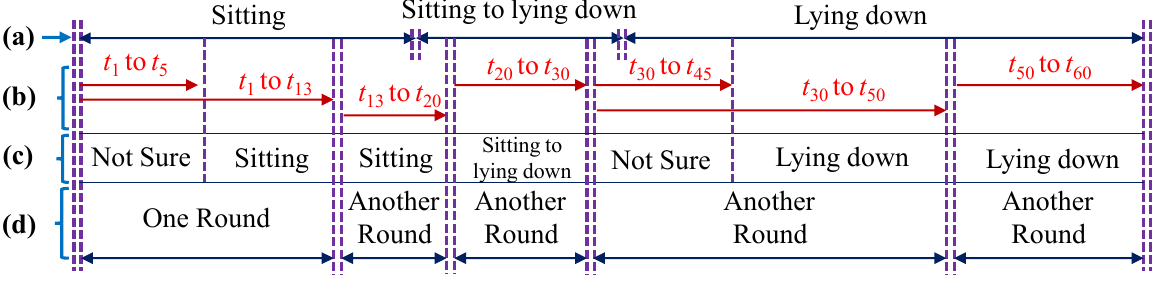
Figure 15. Example of using the automatic rounding method: ( a ) Ground Truth; ( b ) Input Sequence; ( c ) Recognition Process; ( d ) Example rounds.